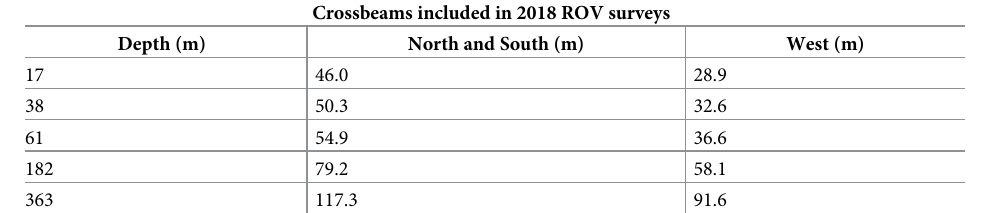
Table 1. Crossbeams included in 2018 ROV surveys Depth (m) North and South (m) West (m) 17 46.0 28.9 38 50.3 32.6 61 54.9 36.6 182 79.2 58.1 363 117.3 91.6 Lengths of Platform Harmony crossbeams surveyed in this study. The east crossbeam was not